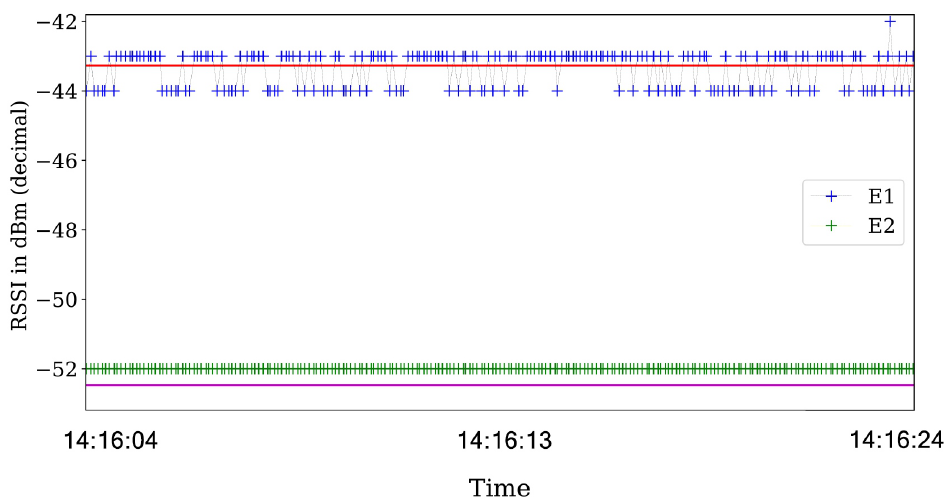
Figure 10. RSS values obtained in an ideal scenario were the red and violet horizontal lines shows the average value across the experiment for each transmitter. The graphs use the timestamp of the packets on the x -axis, and are plotted for only 20 s to show the behavior across the